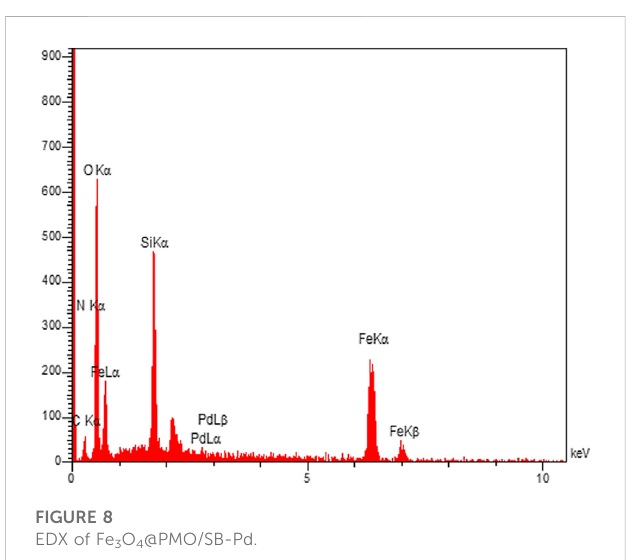
FIGURE 8 EDX of Fe 3 O 4 @PMO/SB-Pd.